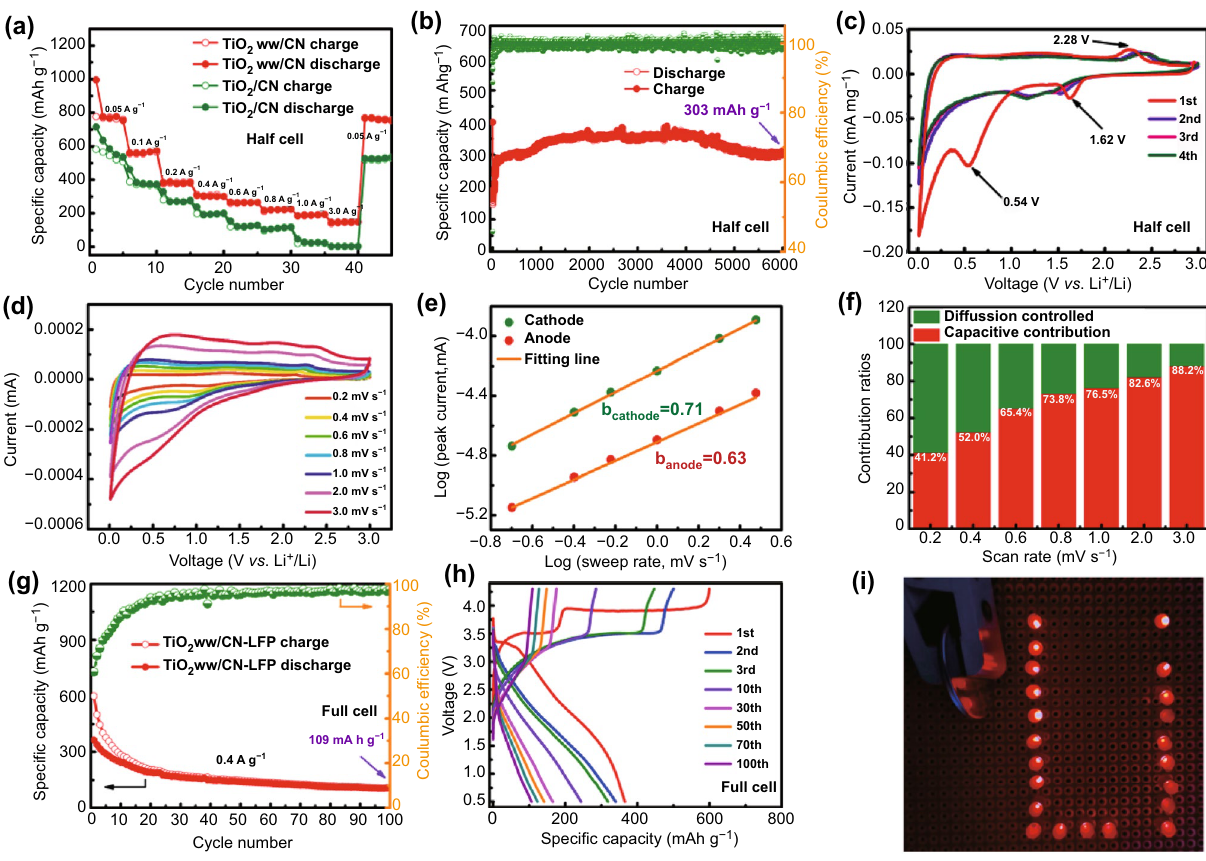
Fig. 3 TiO 2 ww/CN film and TiO 2 /CN film in LHCs: a rate performance at various current densities from 0.05 to 3 A g −1 , at last returning back to 0.05 A g −1 , b long cycling performance at 5 A g −1 for TiO 2 ww/CN electrode; TiO 2 ww/CN film in LHCs: c CV curves of TiO 2 ww/ CN film at 0.1 mV s −1 , d CV curves of TiO 2 ww/CN film from 0.2 to 3.0 mV s −1 , e the log-linear relation in sweep rate ~ peak current, and f columnar diagram of contribution ratios from 0.2 to 3.0 mV s −1 ; (−)TiO 2 ww/CN-LFP(+) full cell: g cycling performance, and h corresponding discharge–charge voltage profiles at 0.4 A g −1 , i the digital picture of 22 LEDs after being